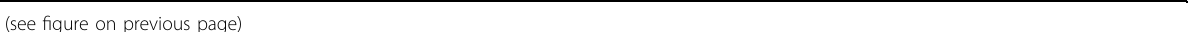
Fig. 4 Impaired vascularization in Wwc2 KO embryo and yolk sac. A Whole mount staining of E11.5 embryos using antibodies against the endothelial marker PECAM1 revealed defects in the vascular system of the Wwc2 KO embryo. Control embryo has normally organized and branched network of vessels. Scale bar = 500 µm. B Vascular patterning in the cranial region of E11.5 control and Wwc2 KO embryos. Scale bars = 50 µm. C Whole mount staining of E11.5 embryos with PECAM1 and anti-SMA antibodies reveals a disorganized vascularization in the neural tube (nt) and an irregular pattern of pericytes in Wwc2 KO embryos. Scale bar = 20 µm. D Whole mount staining of E11.5 yolk sacs with PECAM1 reveals a disturbed vessel branching in the Wwc2 KO yolk sac. Scale bars = 20